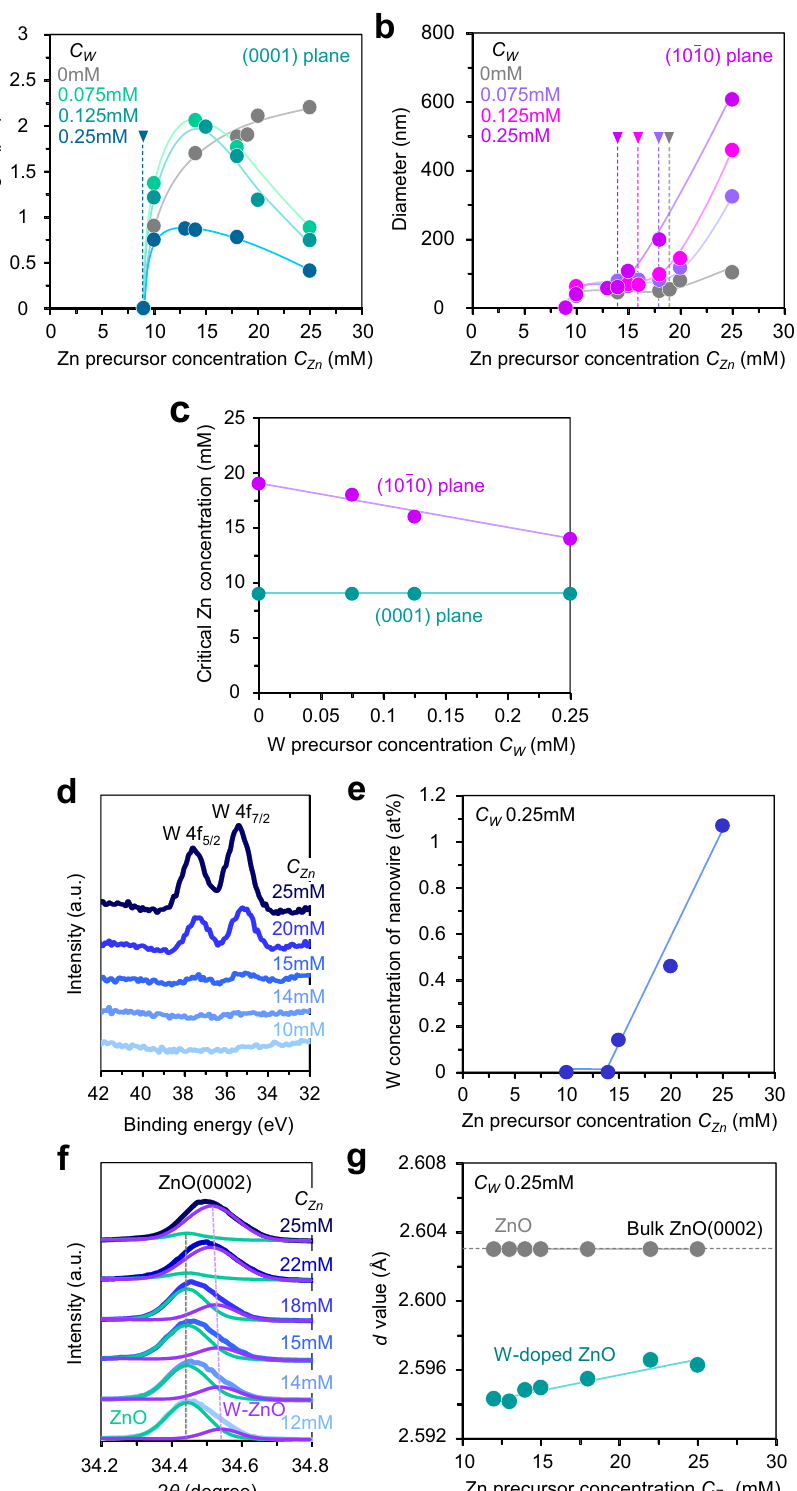
Fig. 2 Morphology, composition, and crystal structure of nanowires with varying C Zn . Zn concentration dependences on a length and b diameter of ZnO nanowires grown with various C W . c Critical Zn concentration for nucleation on (0001) plane and 10 (cid:1) 10